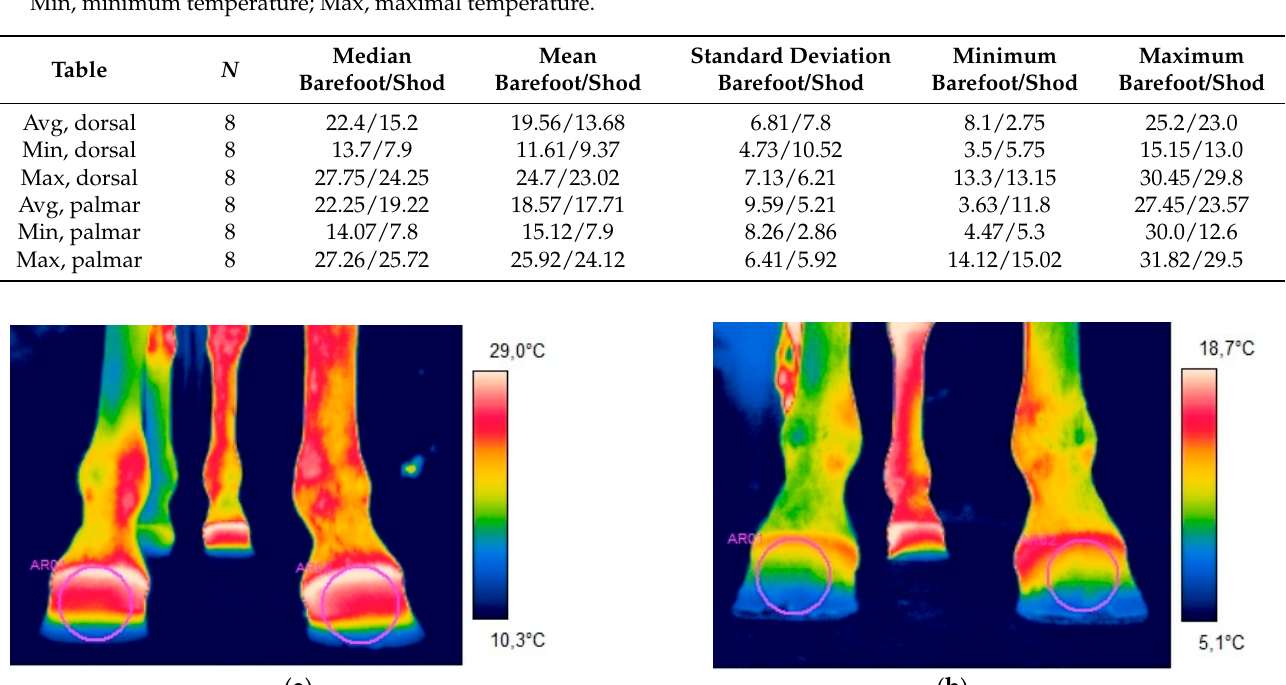
Table 1. Thermographic results received from group 1 before and after shoeing with egg bar shoes. Avg, average temperature; Min, minimum temperature; Max, maximal temperature.